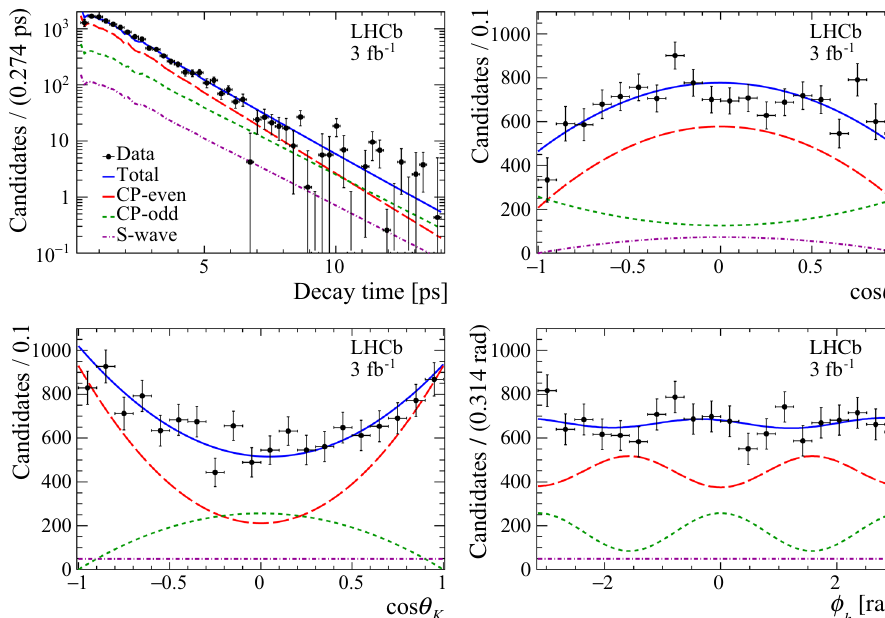
Fig. 6 Decay time and helicity-angle distributions for (data points) B 0 s → J /ψ( e + e − ) φ decays with the one-dimensional projections of the PDF extracted in the maximum-likelihood fit. The solid blue line shows the total signal contribution, which is composed of (long-dashed red) CP -even, (short-dashed green) CP -odd and (dash-dotted purple) S-wave contributions